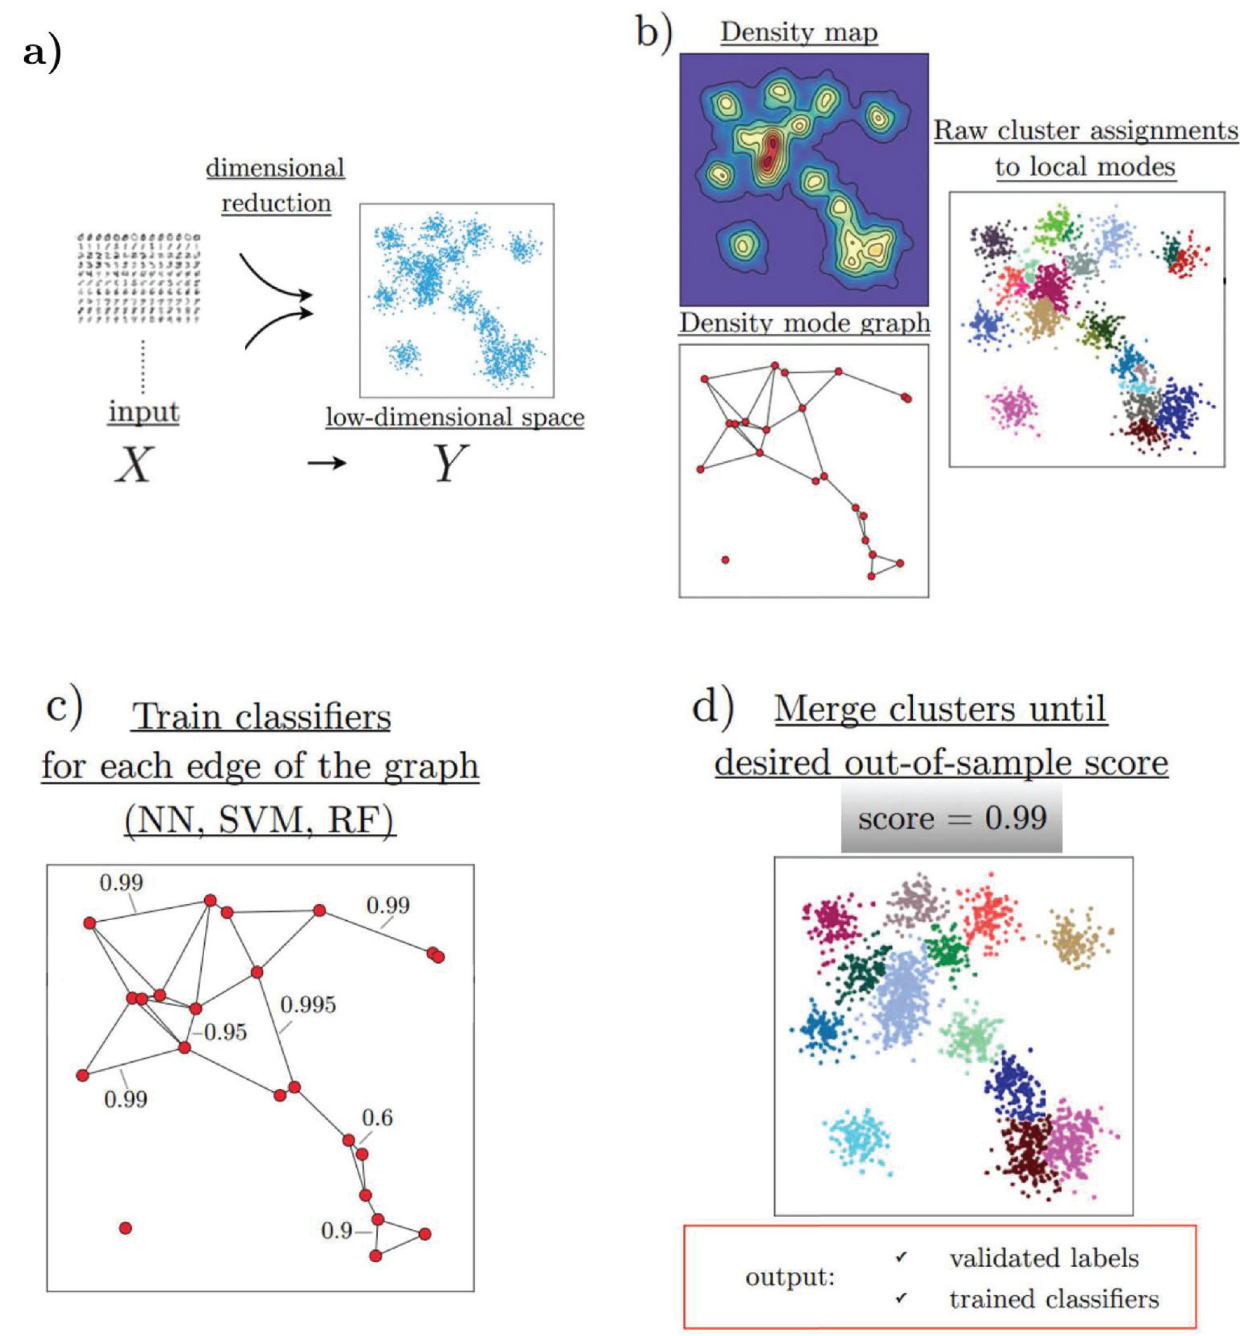
Fig 3. Overview of the hierarchical agglomerative learning approach. (a) For high-dimensional inputs, a dimensionality (c.g. UMAP [31], t-SNE, etc.) reduction step is required in order to obtain reliable density estimates. (b) In low-dimensional spaces, density maps can be easily computed. Initial clusters are selected to be the neighborhood of the density modes (see [17]). (c) A k nearest-neighbor graph is constructed by measuring similarity via the out-of- sample accuracy by training classifiers in the original high-dimensional feature space: each node represents an individual cluster and each edge has an associated weight given by the accuracy of the classifier. (d) Nodes are successively merged by pairs following the procedure until a desired out-of-sample accuracy is reached. The end result consists of an interpretable hierarchical classifier and robust clustering assignments. The classifier can be used to predict the labels of new data and potentially identify outliers.